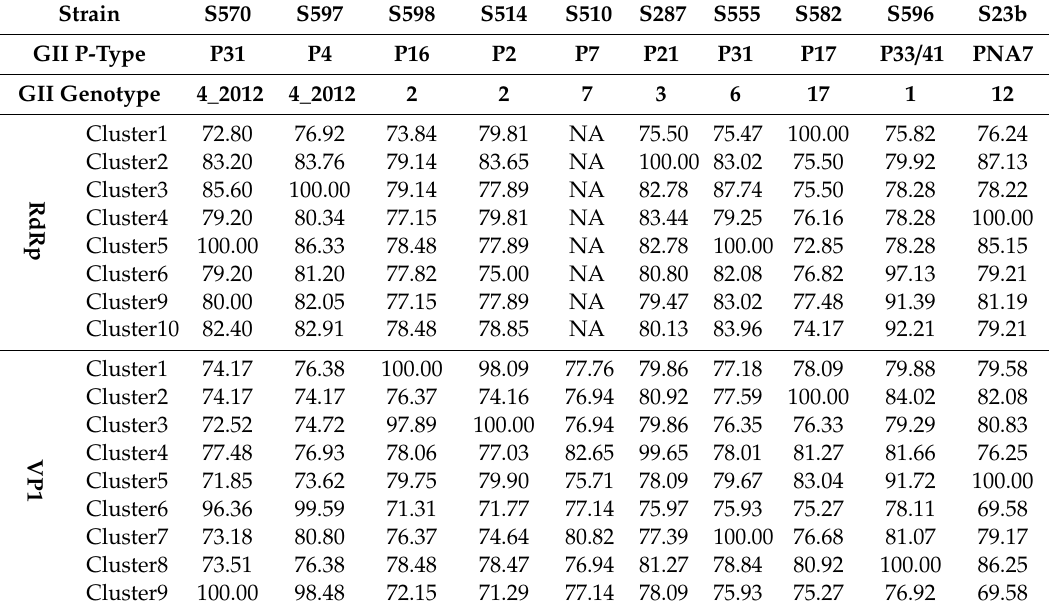
Table 3. Sequence similarity between the NoV strains and the clusters obtained by deep sequencing of nucleic acids (NA)